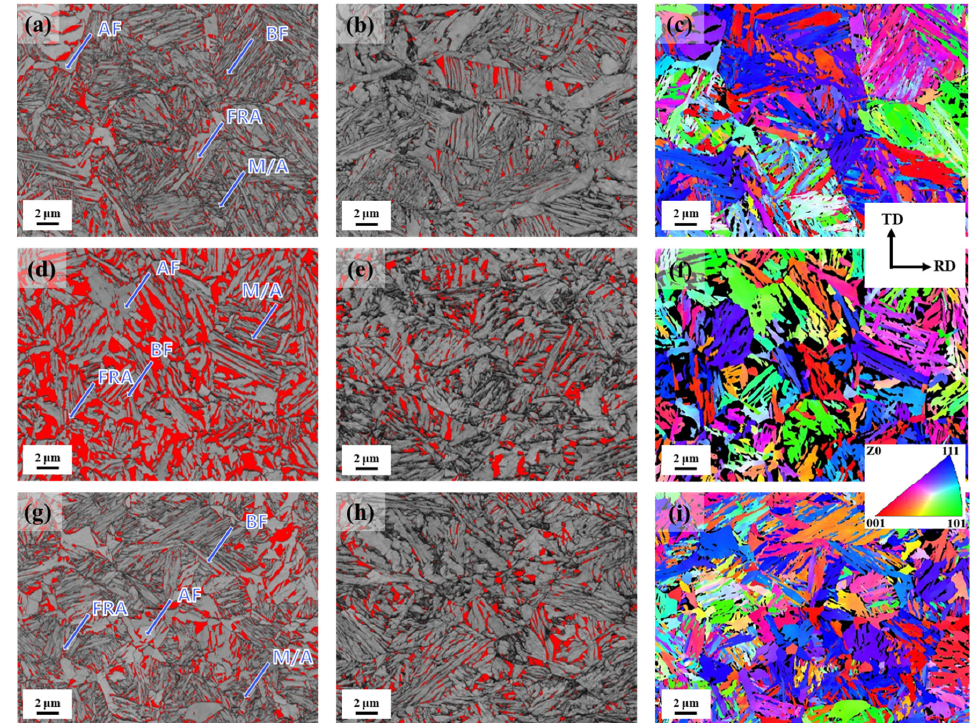
Figure 4. EBSD micrographs of the three samples. The image quality (IQ) with red austenite phase maps before the deformation ( a , d , g ) and after the deformation ( b , e , h ), and the IPF maps ( c , f , i ) of sample BS30 ( a – c ), BS60 ( d – f ), and BS120 ( g – i ) showing bainitic ferrite (the black region is the FCC phase, Z0 direction is related to the